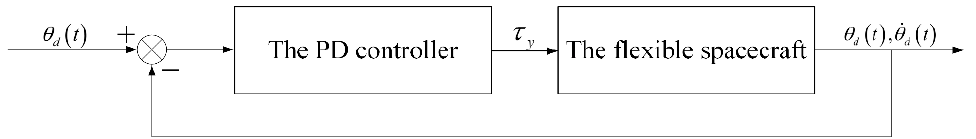
Figure 13. Block diagram of the PD controller.